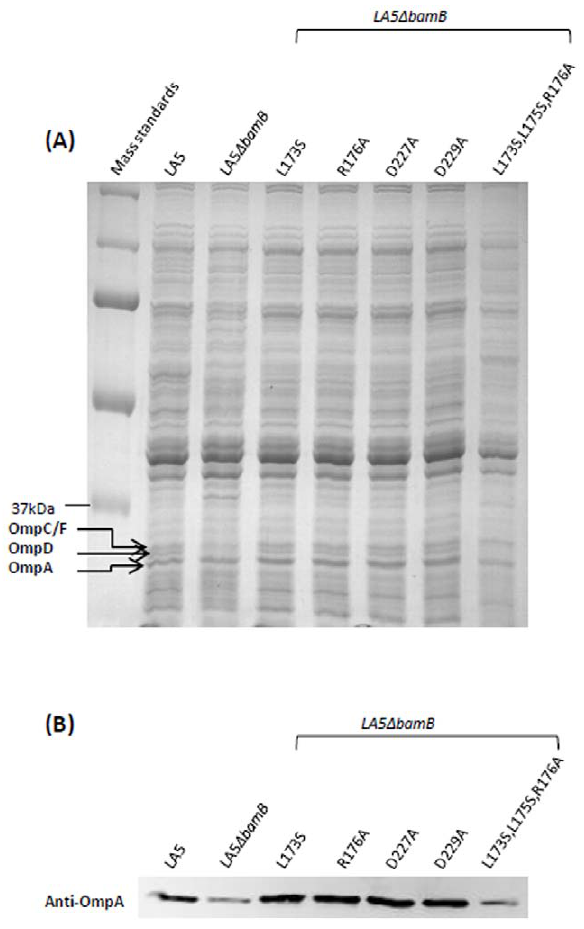
Figure 2. Influence of bamB point mutations on outer- membrane protein level. After culture in LB broth, total membrane proteins of the S. Enteritidis wild-type strain LA5, the LA5 D bamB mutant, or the LA5 D bamB mutant expressing BamB variants were extracted. Membrane proteins were analyzed by 12% SDS-PAGE and either stained with colloidal Coomassie brilliant blue G250 (A) or transferred onto a nitrocellulose membrane and probed with an anti- OmpA serum (B). The positions of OmpC/F, OmpD and OmpA are indicated. Results shown are representative of at least three indepen- dent culture and protein